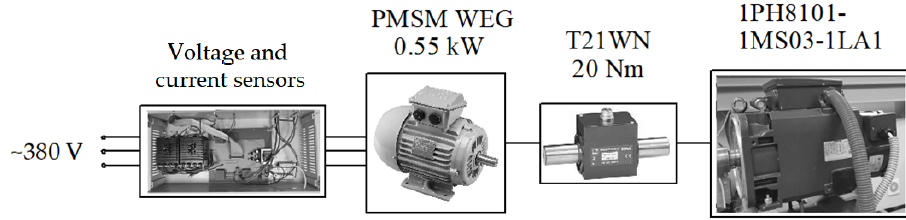
Figure 3. Scheme of the test bench.